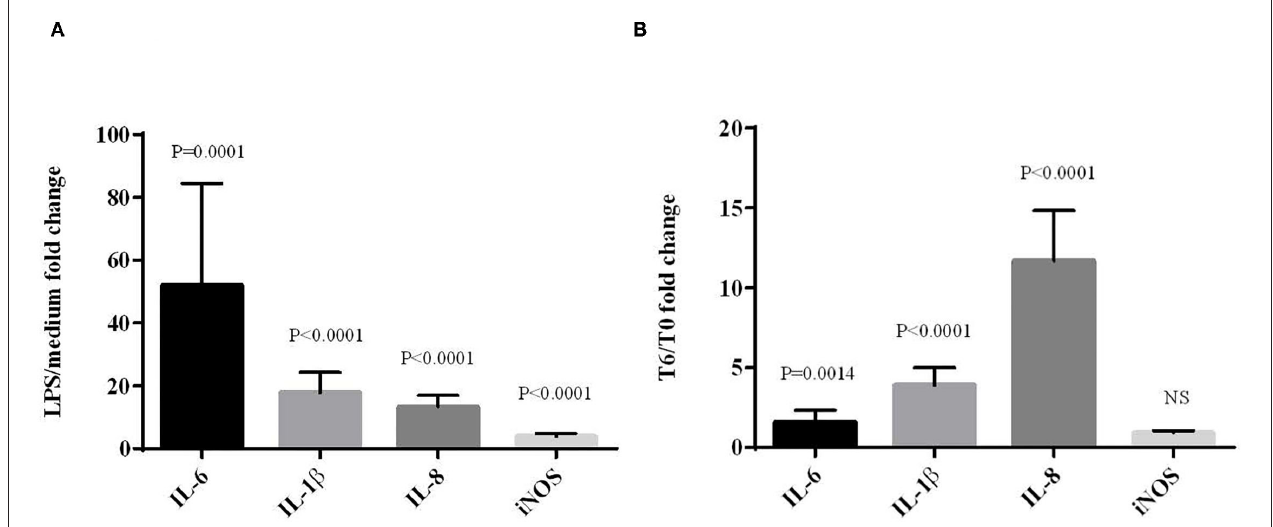
FIGURE 2 | Effects of LPS on the expression of cytokine and iNOS mRNAs in chicken blood cells maintened for 6h in culture ( ex vivo ) with LPS (10 µ g/mL) (A) or from blood sampled 6 hours after subcutaneous LPS injection (100 µ g/kg) ( in vivo ) (B) . mRNA expression was normalized to GAPDH, HPRT and RPS8 reference genes. Data represent mean ± SEM ( n = 12). Data were analyzed by ANOVA or with non-parametric Mann-Whitney test. NS = P > 0.01.